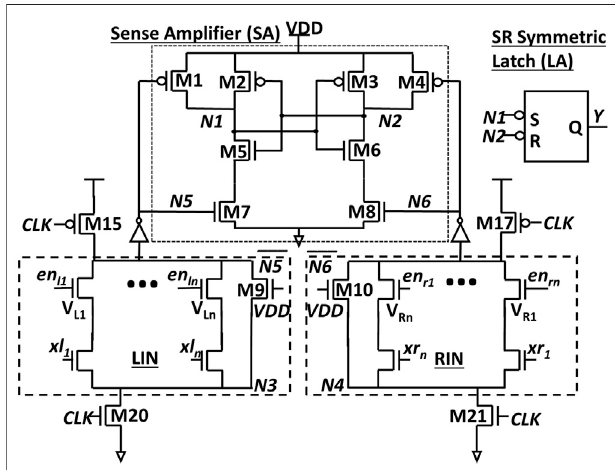
FIGURE 3 | Arti fi cial Neuron (AN)